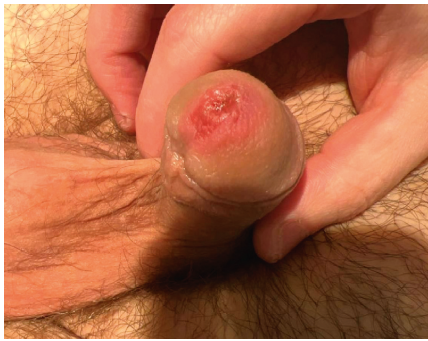
Figure 1: Lesion on the glans penis.